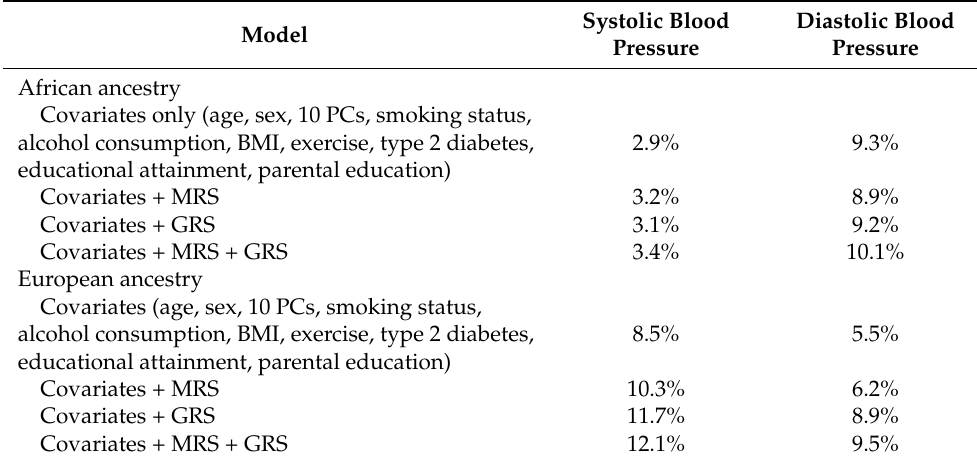
Table 5. Adjusted R 2 of systolic and diastolic blood pressure models by ancestry in the Health and Retirement